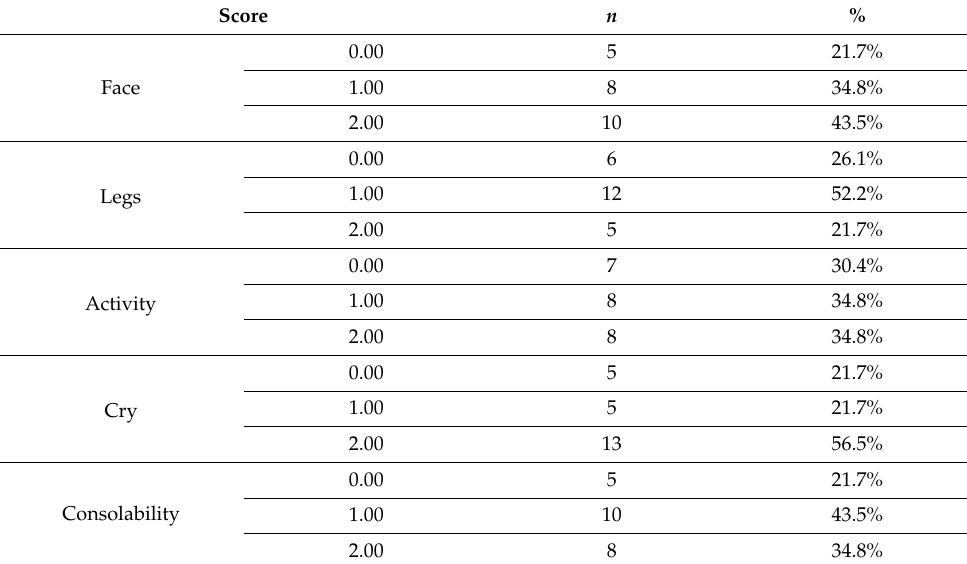
Table 5. Distribution of FLACC scores.